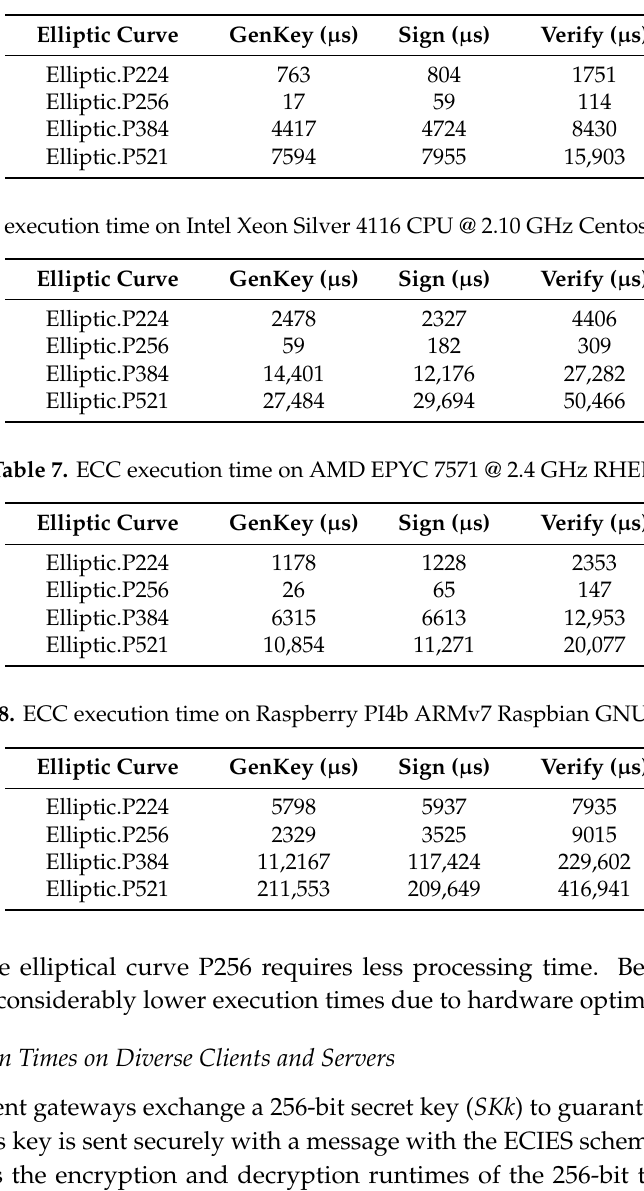
Table 5. Elliptic curve cryptography (ECC) execution time on Intel i7-4980HQ @ 2.80 GHz MacOS 10.15.4.